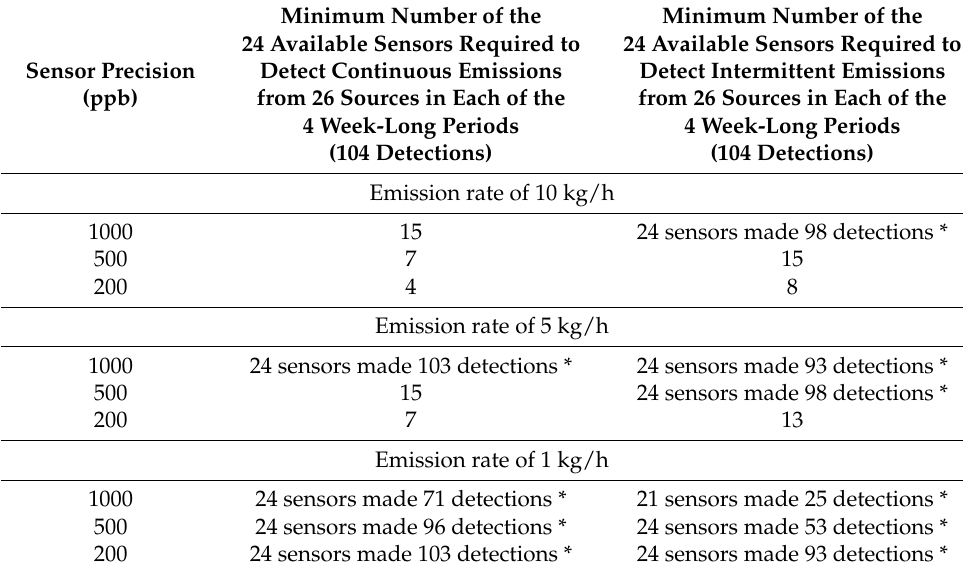
Table 1. Sensors required to detect emissions from each of the 26 emissions sites, in each of the 4 weeks of meteorology evaluated in this work (104 total